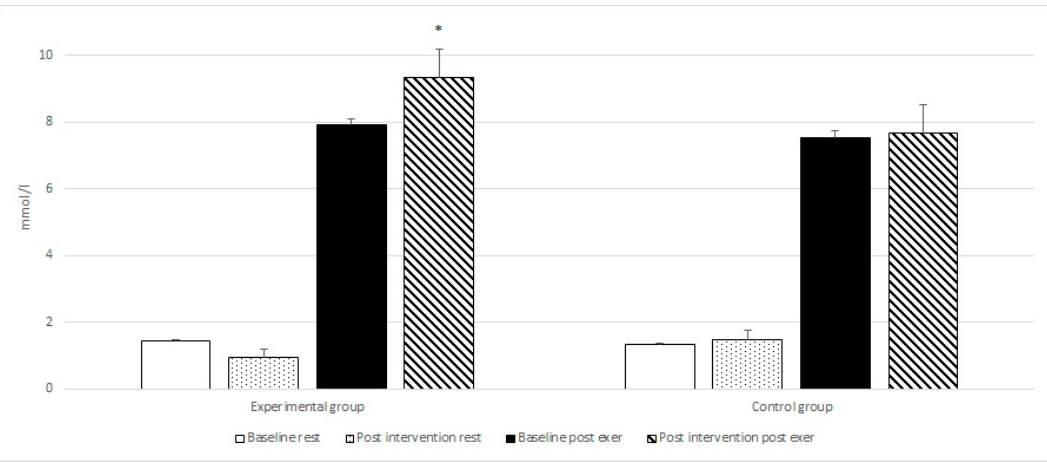
Figure 4. Baseline and post intervention blood HCO 3 − at rest, and post exercise in the experimental and control groups. * statistically significant.